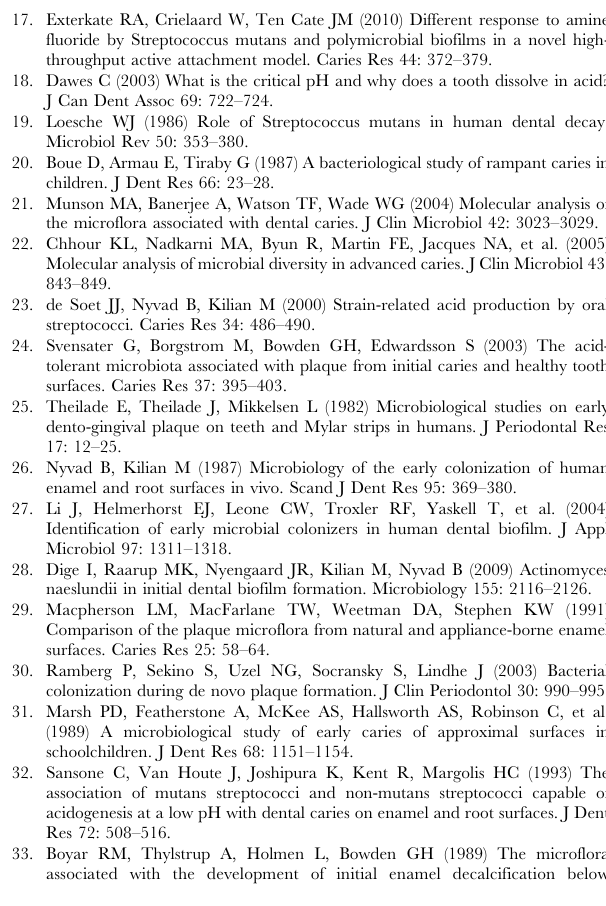
Figure S9 Specificity of FISH probes. Fixed cells of positive and negative control organisms were submitted to FISH with EUB338 (magenta) and the species-specific probes SORA2, ANAES, SMIT, SDOW or SSAN (red). Positive controls S. oralis SK248, A. naeslundii AK6, S. mitis SK24, S. downei HG594 and S. sanguinis SK150 were detected with EUB338 ( A , E , I , M , Q ) and with the respective specific probes SORA2 ( C ), ANAES ( G ), SMIT ( K ), SDOW ( O ) and SSAN ( S ). Negative controls were detected with EUB338 ( B , F , J , N , R ), but not with the respective specific probes ( D , H , L , P , T ). Bars = 10 m m. Figure S10 Calibration of C-SNARF-4. Black diamonds show green/red-ratios of C-SNARF-4 fluorescent emissions at different pH values, as determined in HEPES buffer. A sigmoid function was fitted to the ratios and used as calibration curve for the biofilm experiments. (TIF) Video S1 Biofilm hybridized with probes ANAES (green) and EUB338 (red). EUB338 visualizes the entire bacterial population, while ANAES specifically detects A. naeslundii . Cells of A. naeslundii predominantly colonize basal layers of the biofilm and are rarely observed in the middle and upper third. Field of view